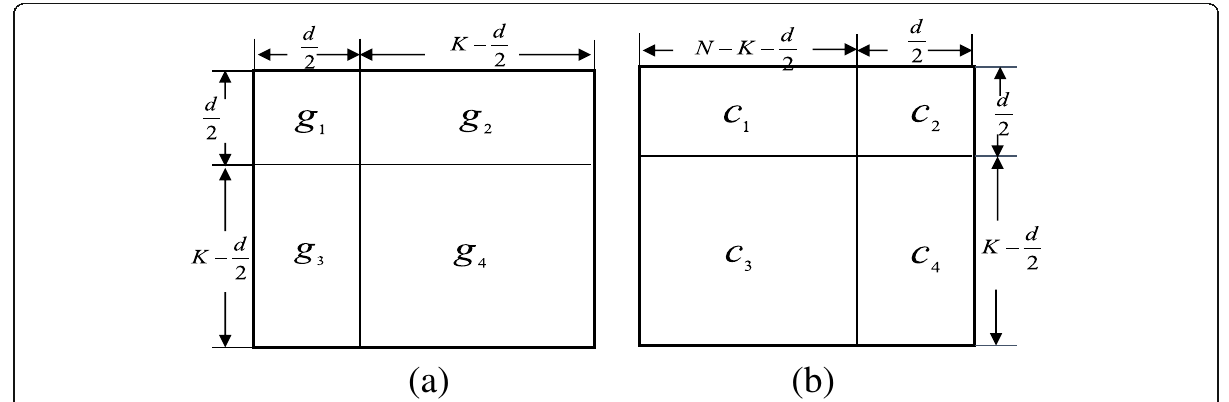
Fig. 10 Matrix segmentation at N = 2 n : Fig. 9a can be partitioned and written as several submatrices of g 1 , g 2 , g 3 , and g 4 shown in a . Fig. 9b can segmented into submatrices of c 1 , c 2 , c 3 , and c 4 shown in b . The submatrix c 2 is a zero